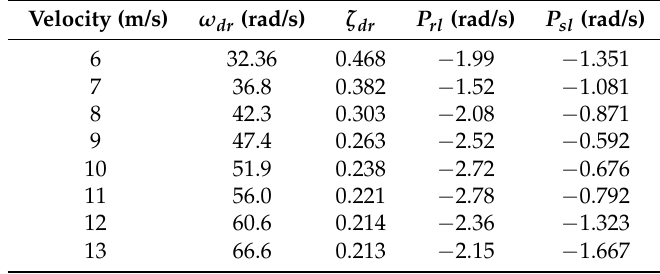
Table 11. Variation of natural frequencies and damping ratio of lateral modes of